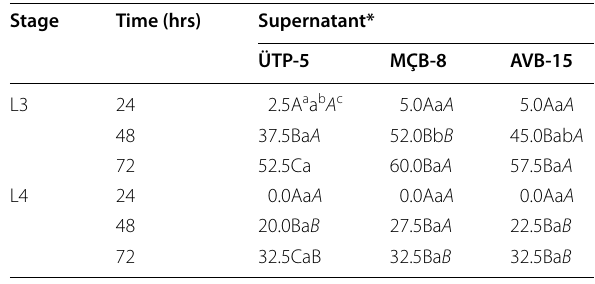
Bold numbers indicate statistical significance at level alpha